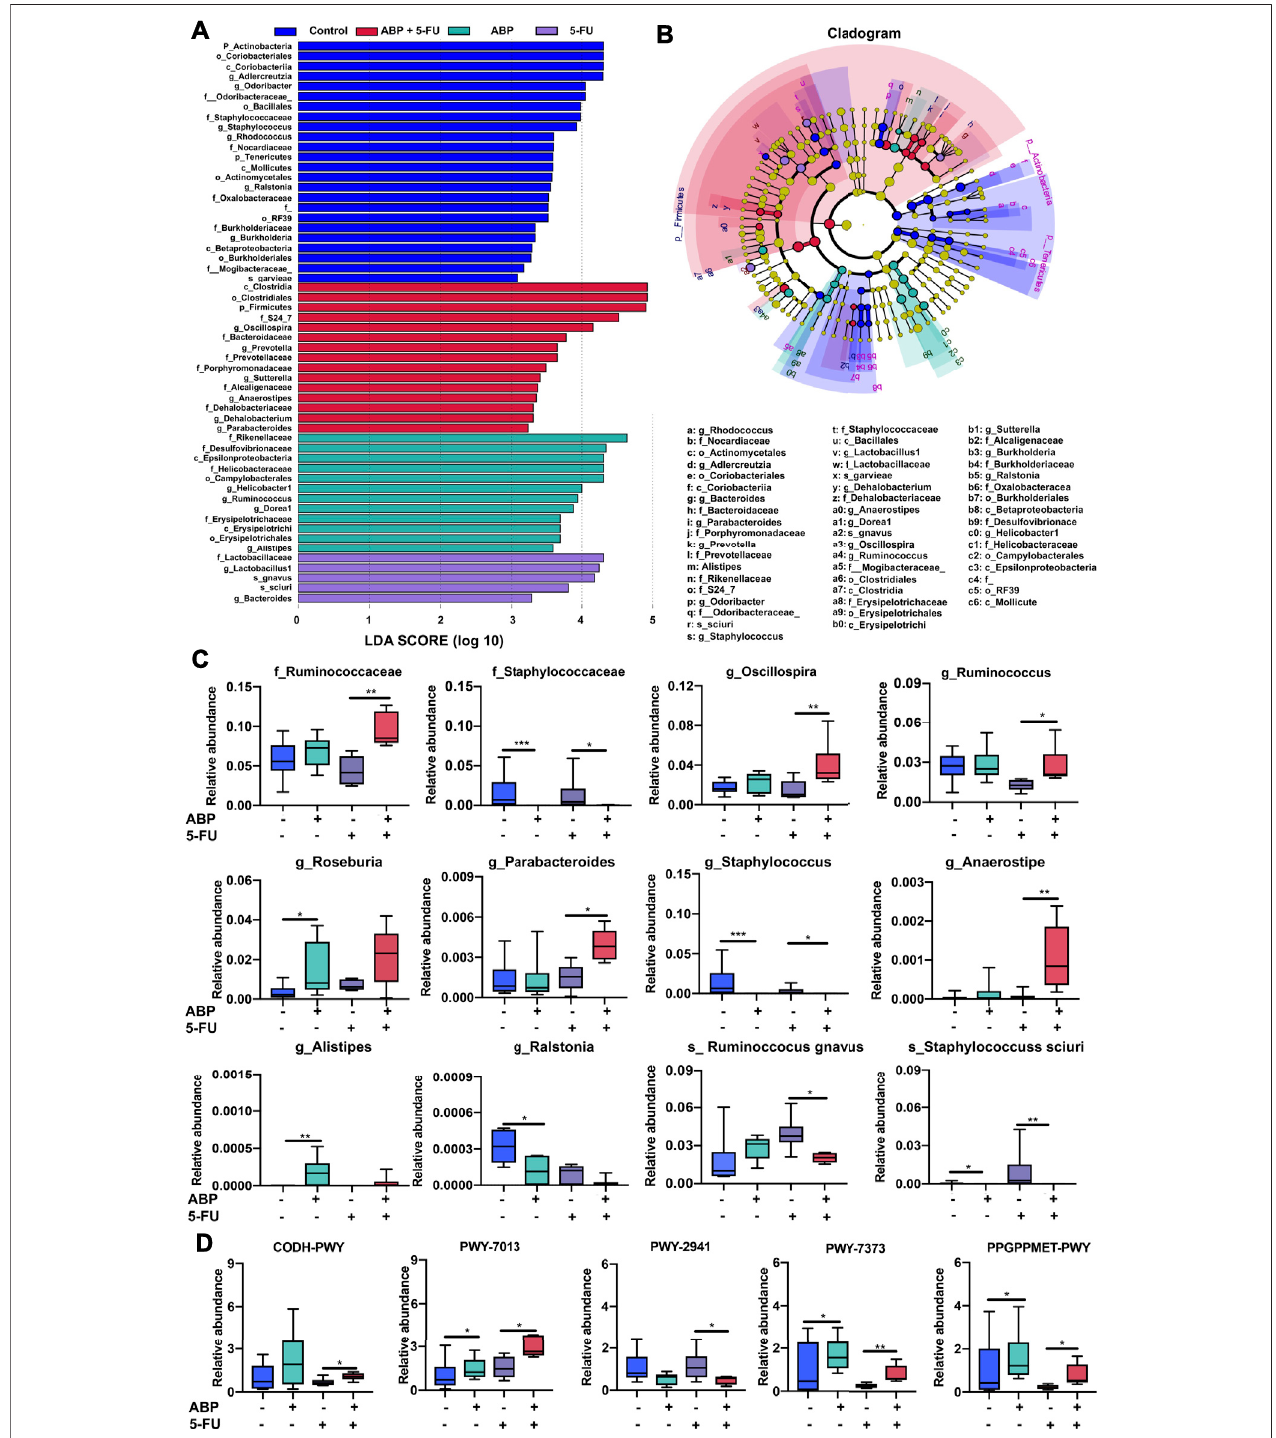
FIGURE 8 | ABP treatment leads to the enrichment of bene fi cial bacteria and in fl uences metabolic pathways. (A-B) Bacterial taxa differences among the four groups, observed using LEfSe analysis. (C) Box plots demonstrating the characteristic bacteria at the family, genus, and species levels. (D) Difference in functional metabolic pathways among the groups. * p < 0.05, ** p < 0.01, *** p < 0.001.